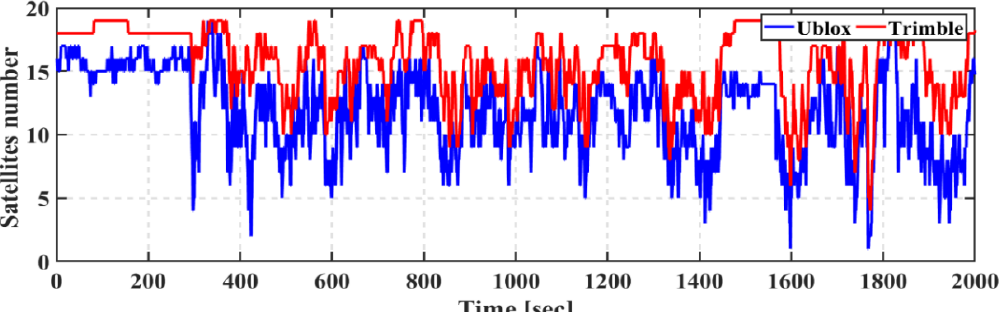
Figure 20. Third field trial: East positioning error of real-time TC GNSS PPP/INS for Ublox–Xsens, Trimble–Xsens, Ublox– Stim, and Trimble–Stim solutions. Figure 21. Third field trial: East positioning error of real-time TC GNSS PPP/INS for Ublox–Xsens, Trimble–Xsens, Ublox– Stim, and Trimble–Stim solutions. The root-mean-square (RMS) and mean of positioning errors of the Ublox–Xsens, Trimble–Xsens, Ublox–Stim, and Trimble–Stim integrated solutions in the east, north, and up directions are presented in Table 7. The RMS values of the Ublox–Xsens positioning